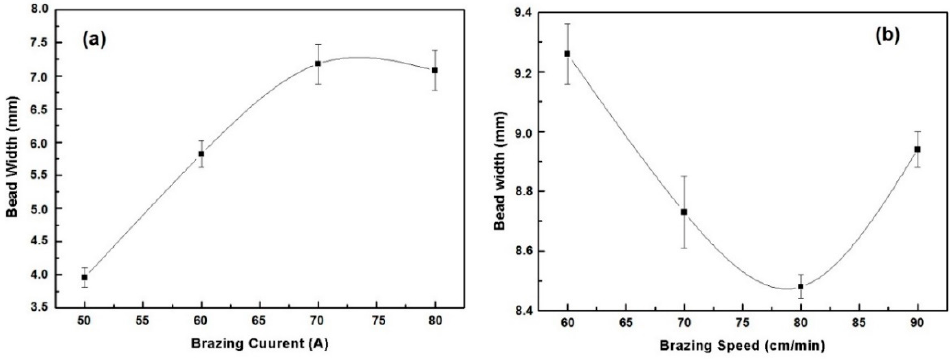
Figure 5. Bead face width as a function of ( a ) arc current (at 80cm / min), and ( b ) arc speed (at 70A).